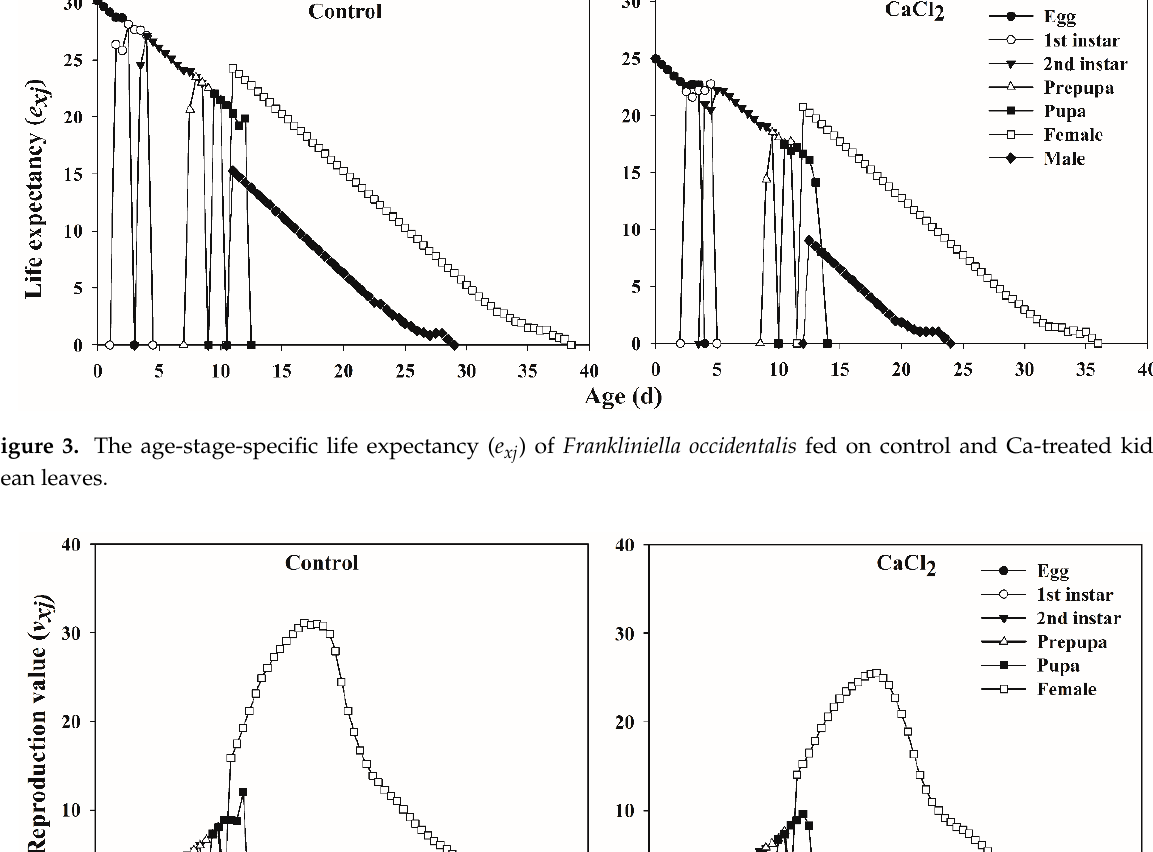
net maternity ( l x m x ) of Frankliniella occidentalis fed on control and Ca-treated kidney bean leaves.